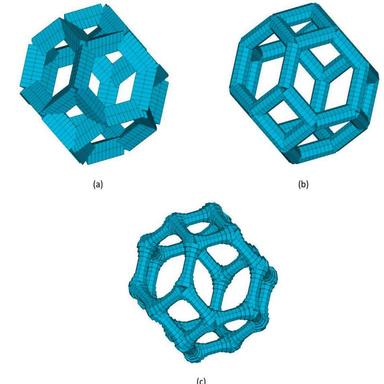
The FE beam models of the Kelvin cell: (a) triangular cross-section model, (b) circular cross-section model and (c) circular cross-section with discrete variation along the ligaments.